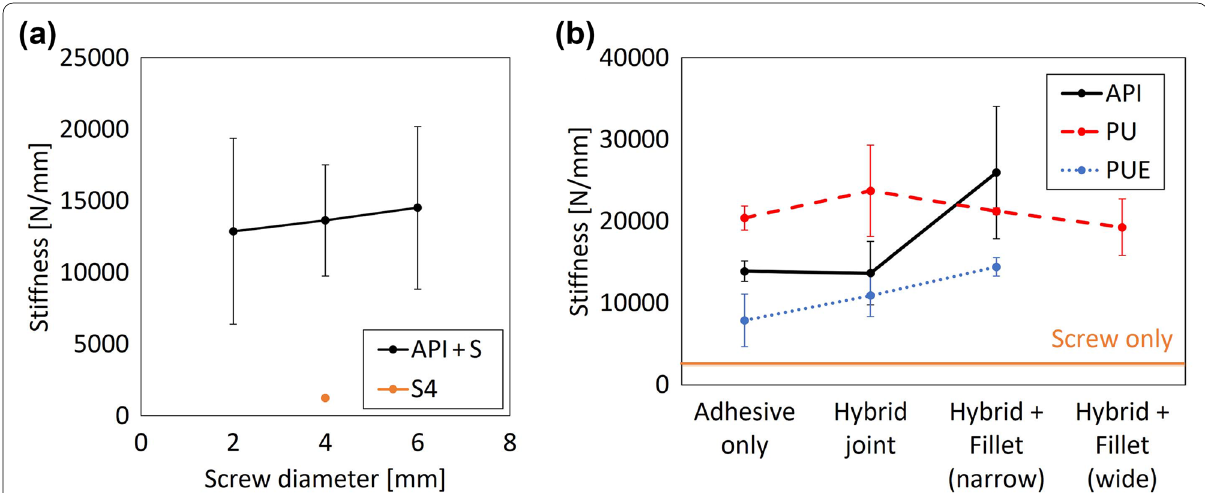
Fig. 6 a Effect of screw diameter on stiffness (API), and b effect of joint type on stiffness. Error bars denote standard